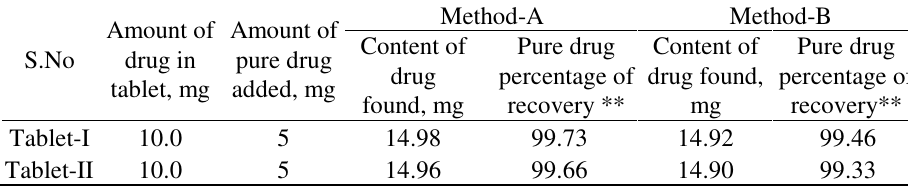
Table 2. Assay and recovery of adefovir dipivoxil in pharmaceutical